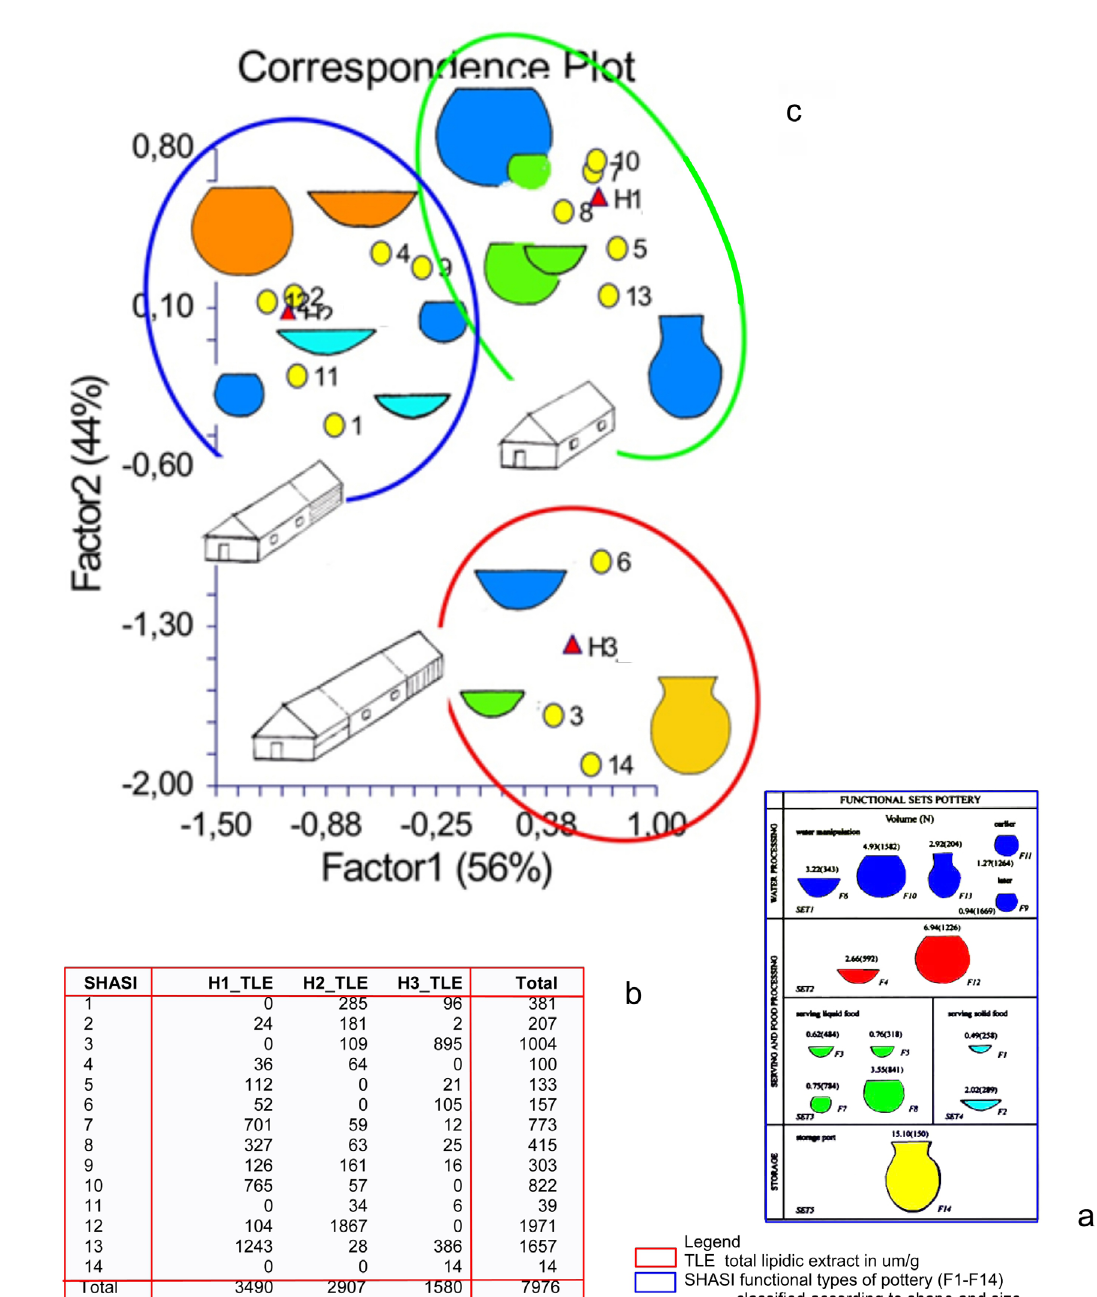
Figure 3: Bylany (distr. Kutná Hora), a) Formal intepretation of functional pottery types (after Pavlů 2000, Fig. 4.5.4a, b) TLE (Total Lipidic Extracts) in types SHASI. c) Interpreted functional types and types of houses within the TLE space (data compare in Mátlová et al., in press